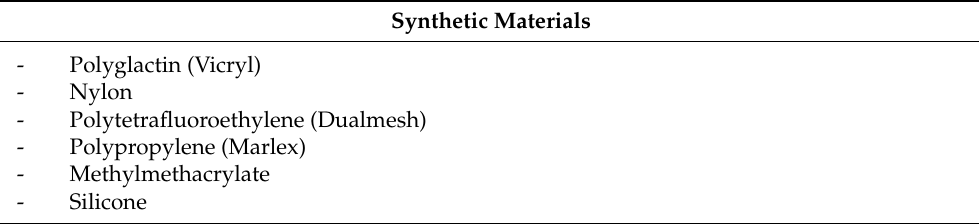
Table 3. Synthetic materials for the